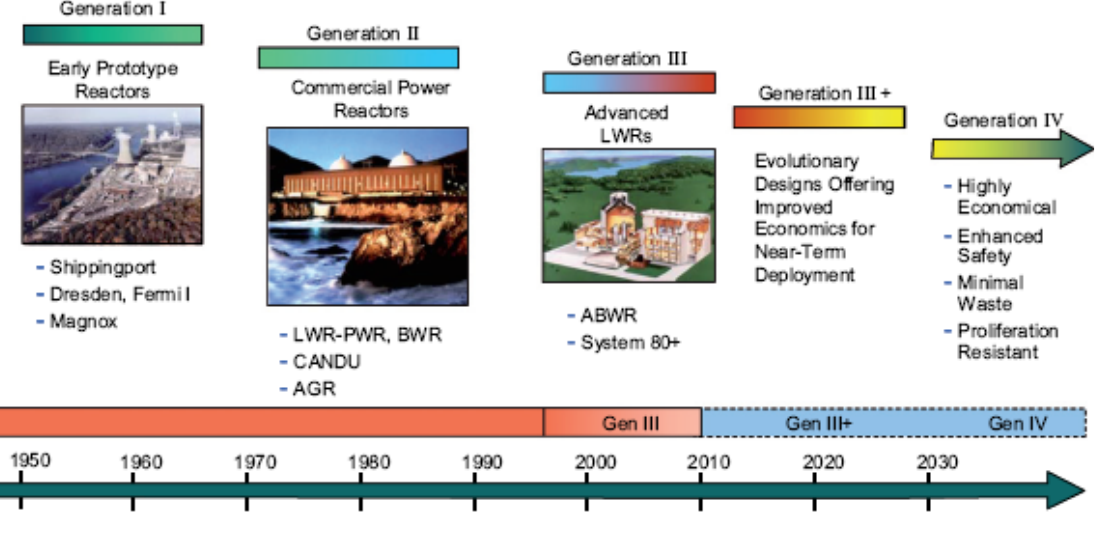
Figure 34. Subsequent generations of nuclear power plant concepts. © OECD Nuclear Energy Agency, reproduced from